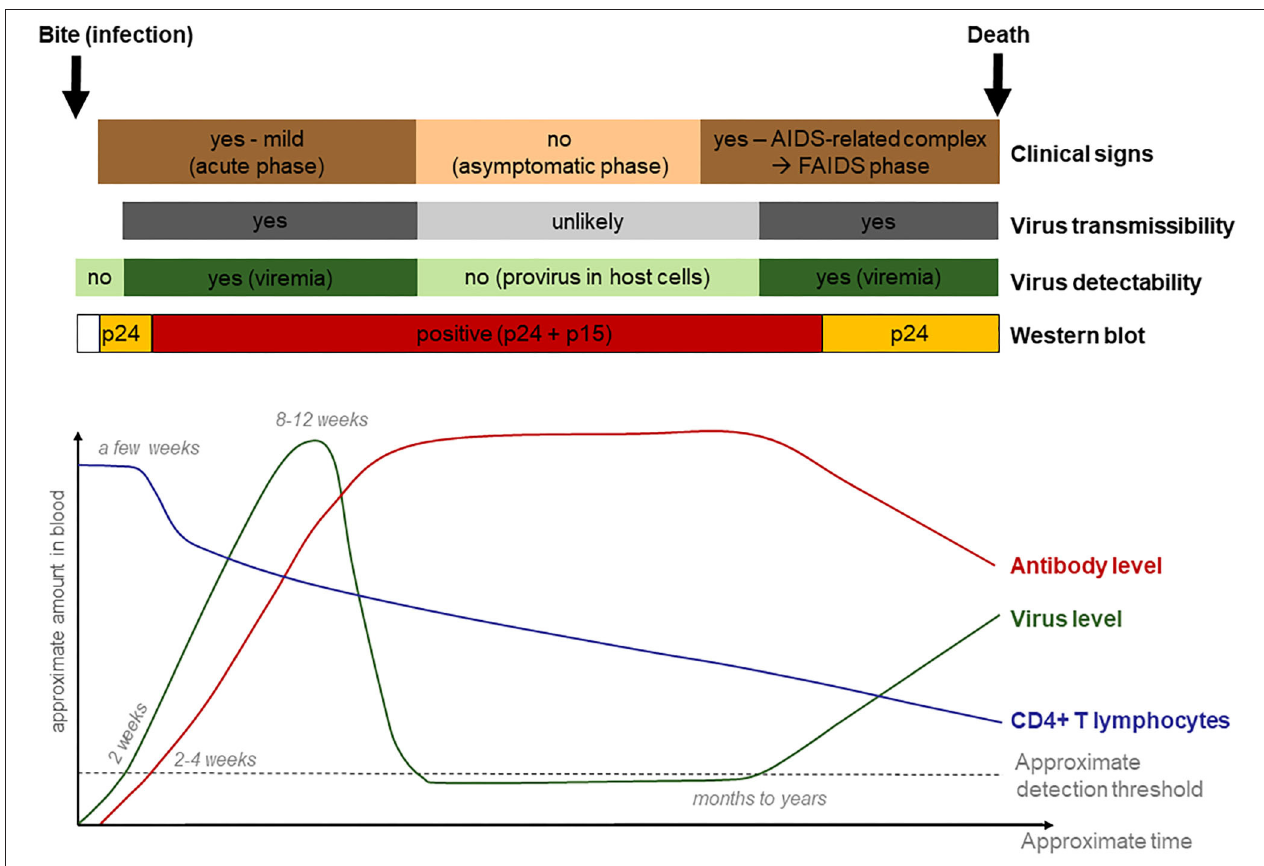
FIGURE 10 | Tentative graphical representation of feline immunodeficiency virus infection dynamics, with clinical manifestations and diagnostic